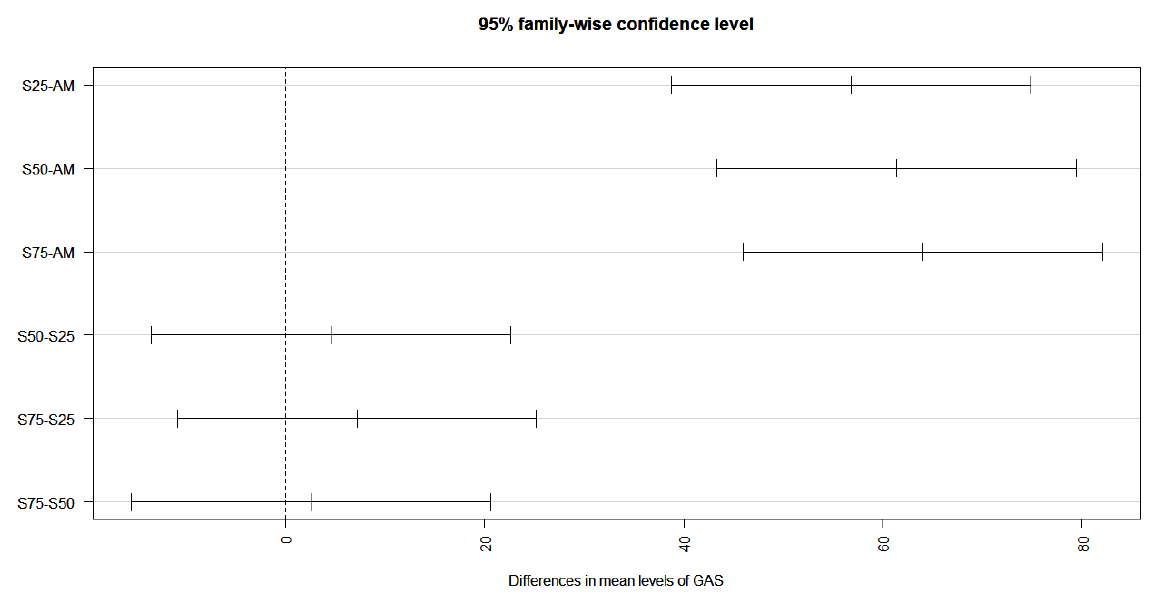
7 of 17 Figure 3. Line diagram, showing the effect of SO 2 exposure on soil population of root-knot nema- tode, in five cucurbits. The orthogonal contrasts prepared between SO 2 levels and galling on pumpkin showed mostly significant interactions between SO 2 and M. incognita , as only a few con- trasts lay on the broken vertical line of no difference. Maximum synergistic interaction with regard to an increase in the galling was observed at 75 ppb SO 2 , as this contrast was situated at the furthest location from the line of no difference (Figure 4). The interactive and individual effects of SO 2 , crops and M. incognita were significant at p ≤ 0.001 (Table 1). Table 1. Effect of intermittent exposures of SO 2 (ambient, 25, 50, and 75 ppb) on the number of galls and egg masses caused by root-knot nematode ( M. incognita ) on the roots of five cucurbits. Cucurbits